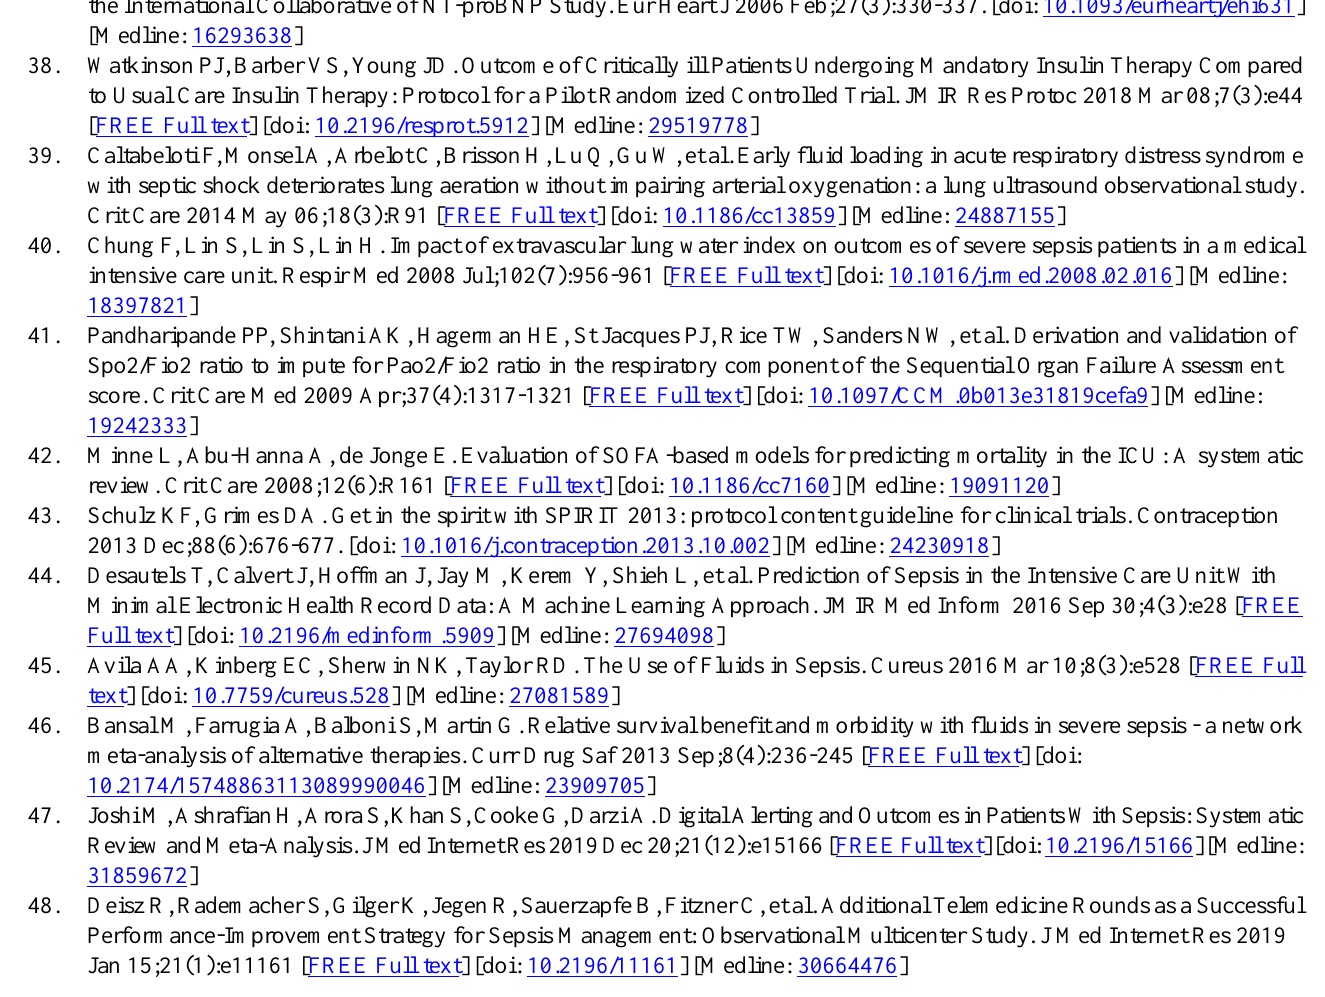
Abbreviations ARISE: Australasian Resuscitation in Sepsis Evaluation BLUE: Bedside Lung Ultrasound in Emergency CONSORT: Consolidated Standards of Reporting Trials FALLS: Fluid Administration Limited by Lung Sonography